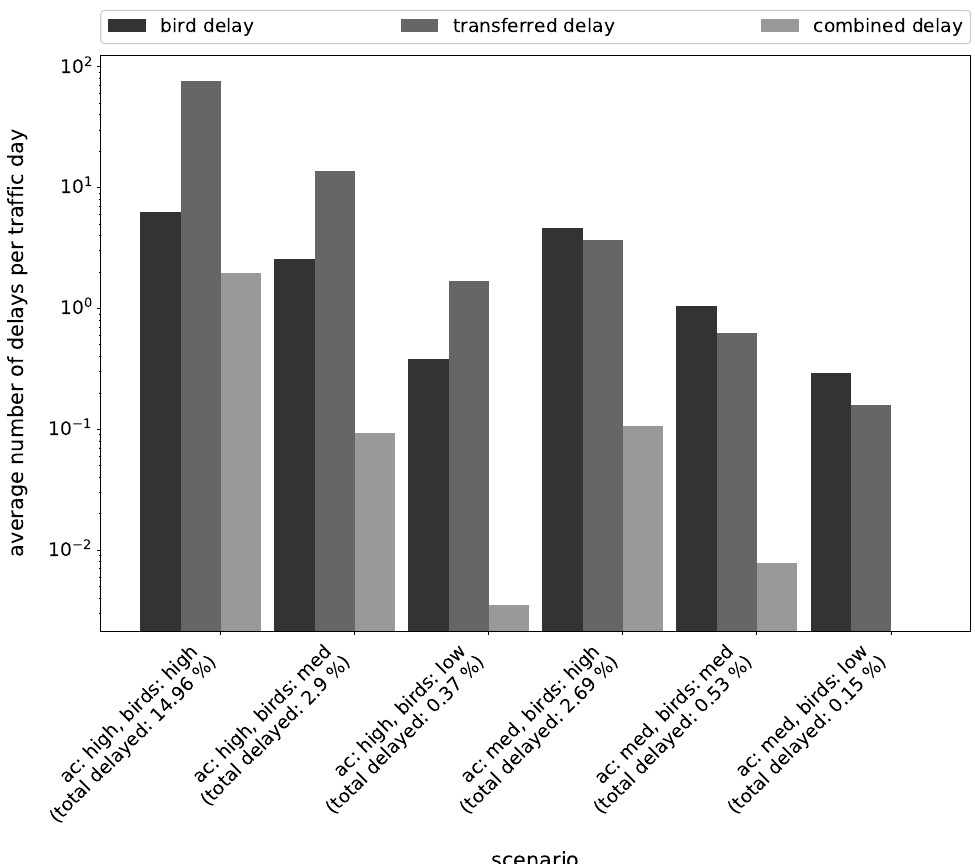
Figure 6. Number of the different delay types per traffic day (logarithmic